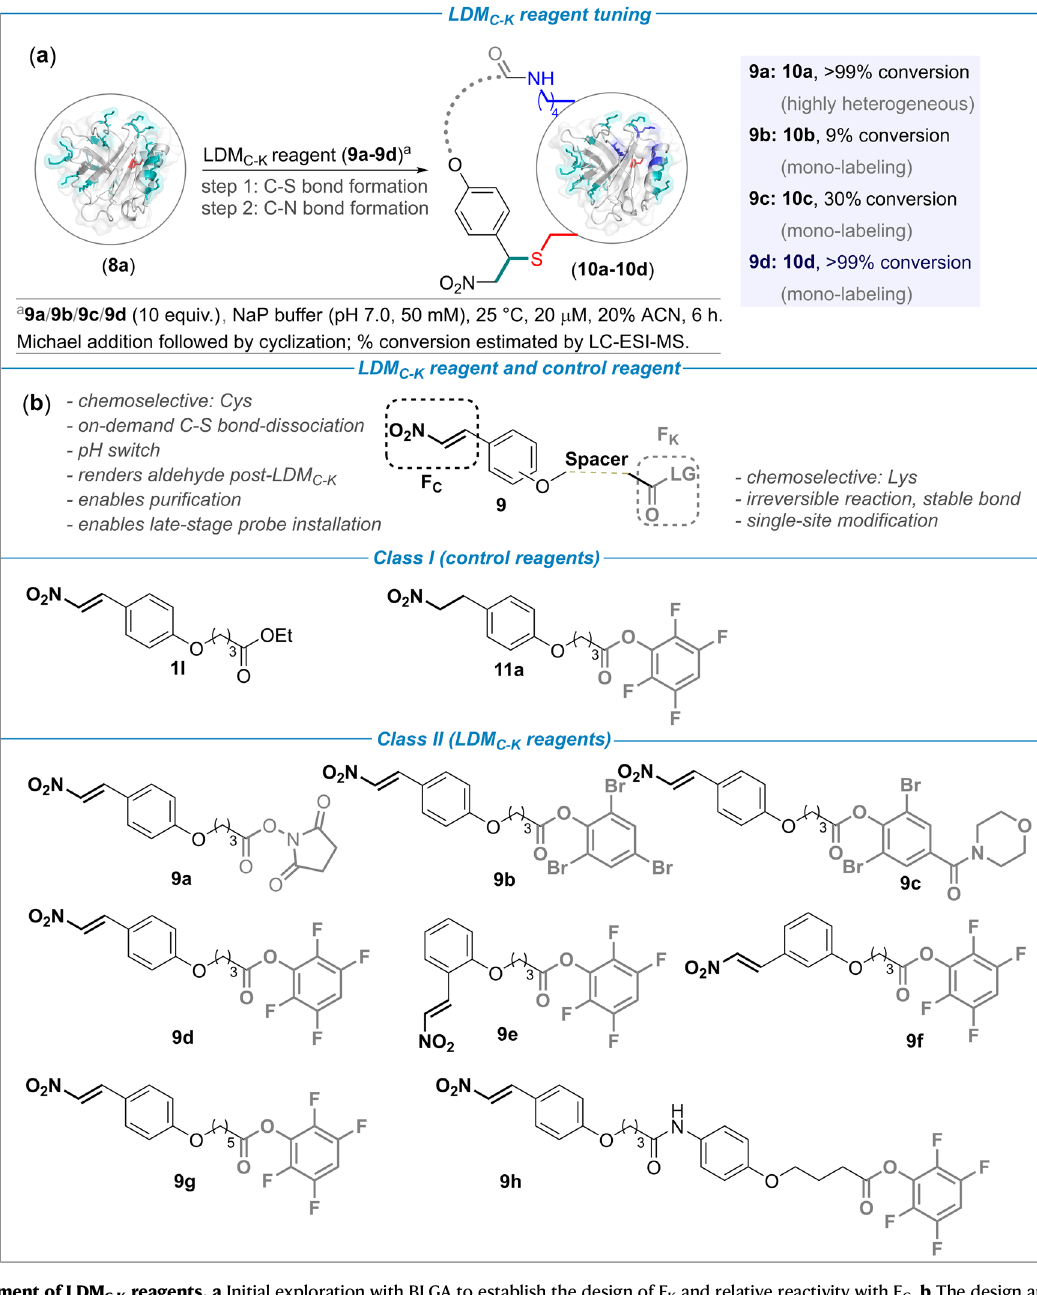
Fig. 3 | Development of LDM C-K reagents. a Initial exploration with BLGA to establish the design of F K and relative reactivity with F C . b The design and synthesis of potential LDM C-K and control reagents (for synthesis, see Supplementary Figs. 1 –